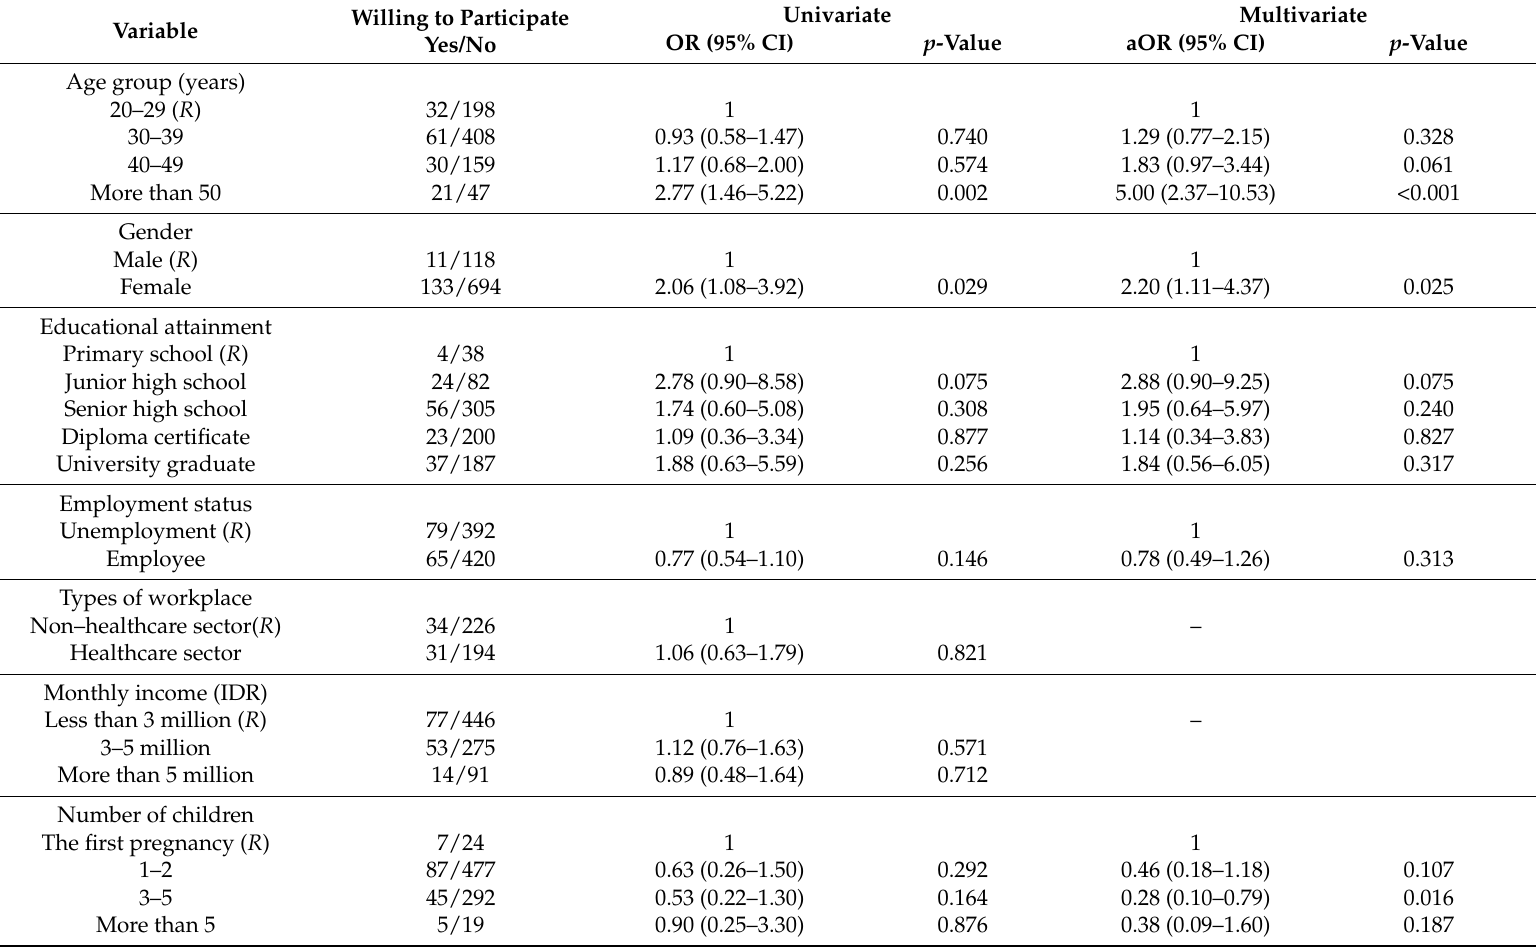
Table 2. Univariate and multivariate logistic regression analysis showing predictors of willingness to participate (the second project) in a Zika Vaccine Trial (Willing vs. Not willing) ( n =